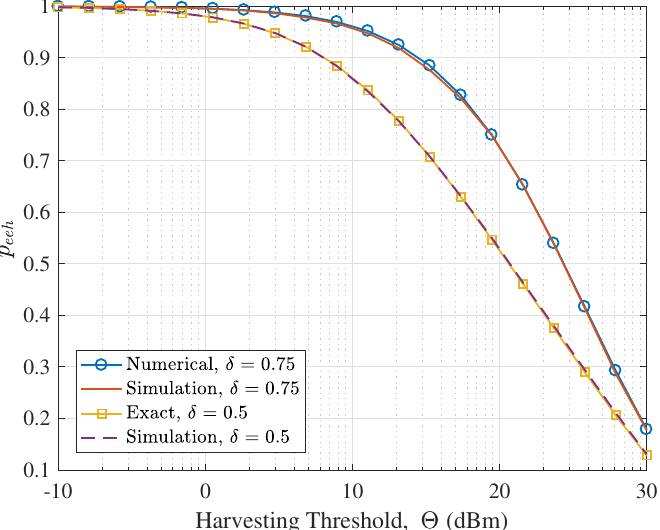
Figure 2. Effective energy earvesting probability for LSWN-IC with λ t = 0.1, α = 4, η a = 1 and P et = 30 dBm.